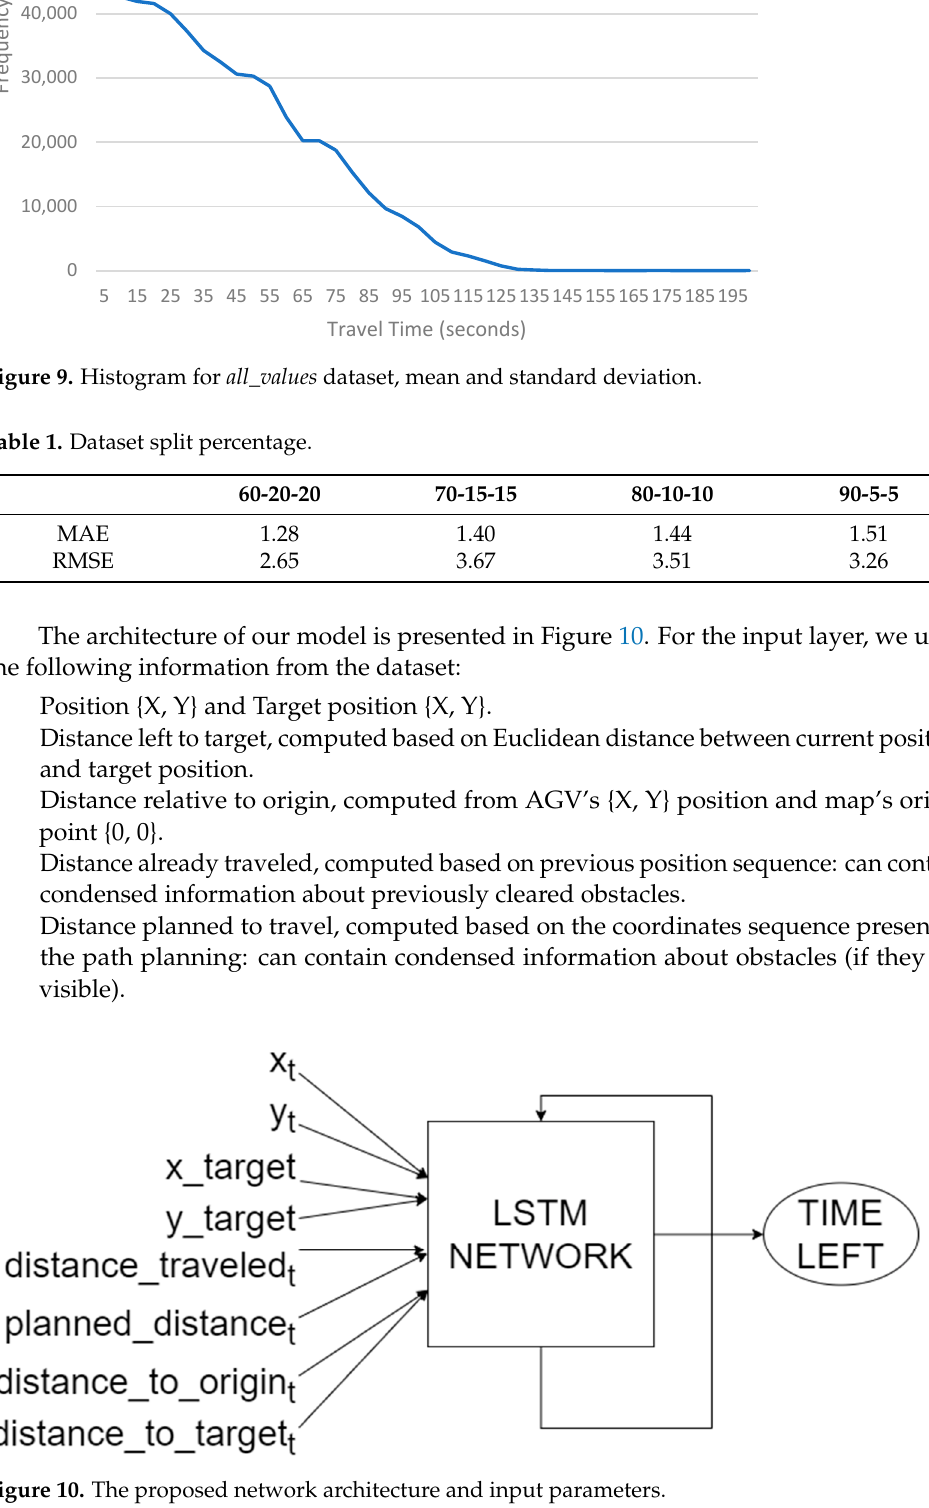
Figure 10. The proposed network architecture and input parameters.